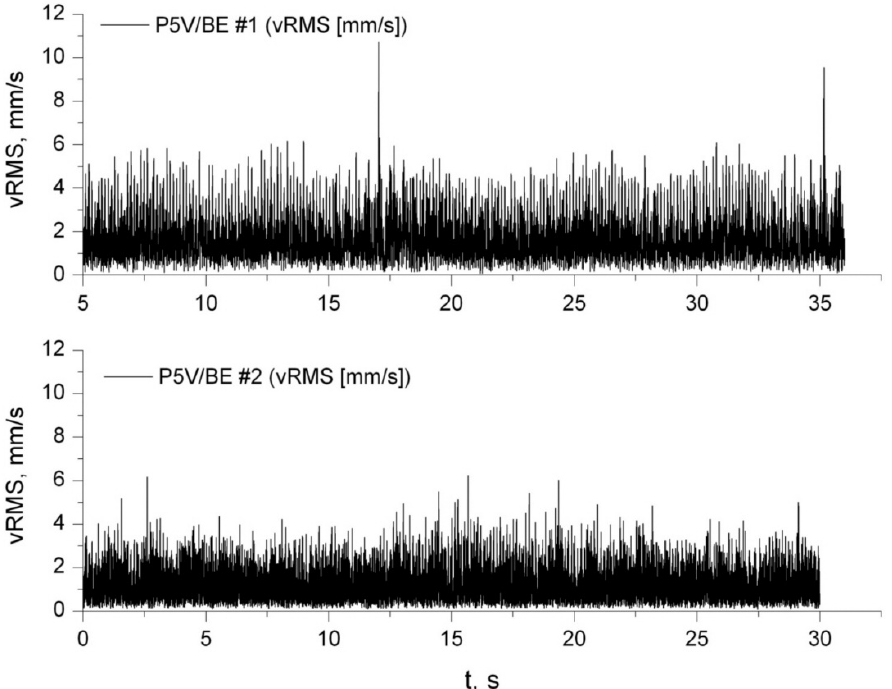
Figure 5. Time waveform of vibration velocity in the vertical direction at point P5 (on the bearings on the right-hand-side of output shafts) in bucket elevators BE#1 ( upper diagram ) and BE#2 ( lower diagram ).